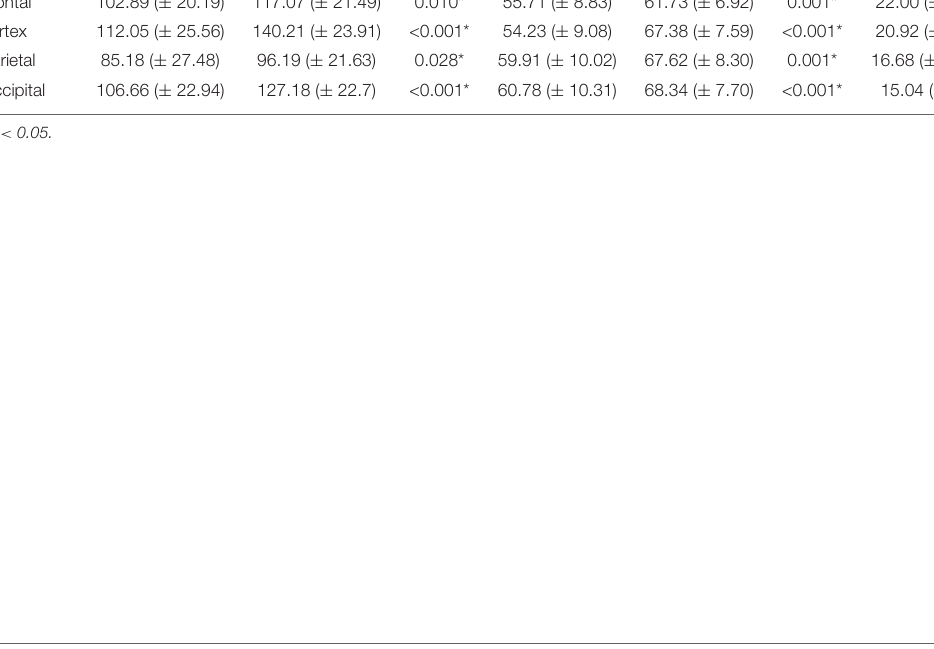
TABLE 3 | Comparisons of hair parameters in FPHL patients between male and female. Scalp